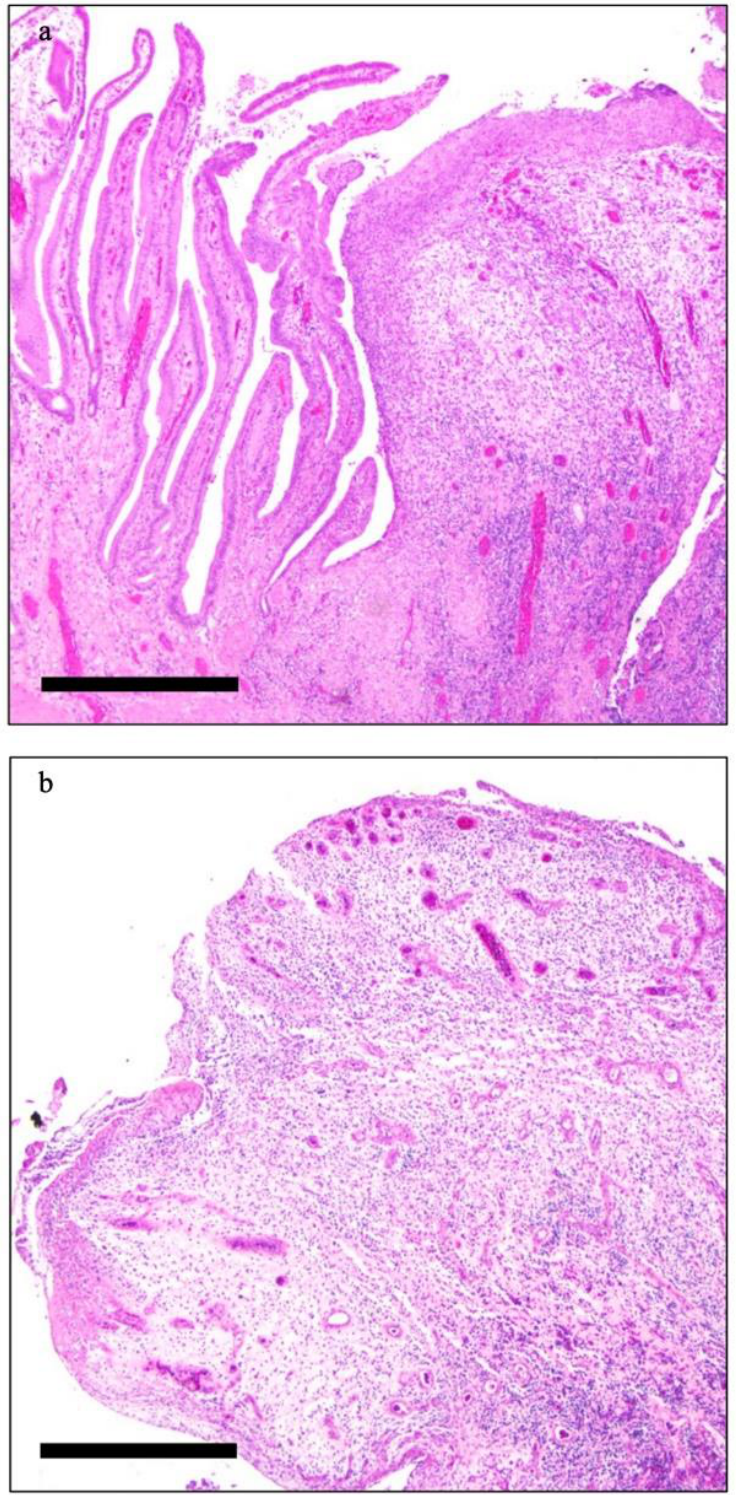
Figure 2. Histological image demonstrating papillary hyperplasia and an inflammatory pseudopolyp ( a ) and particular representative picture of one of the described inflammatory pseudopolyps observed in the gallbladder showing an ulcerated sessile mucosal projection characterized by edematous vascularized stroma with mixed type inflammatory infiltration ( b ) (scale bar 500 um). Acute acalculous cholecystitis, even complicated by perforation, often occurs in post- surgical adults while in children it is often caused by infectious disease or immune-medi- ated disorders. Moreover, it can be associated with cardiovascular diseases, in particular with coronary artery disease and in children with Kawasaki Disease [1–4]. The etiology of acalculous cholecystitis is often unknown, even though it has been correlated with biliary hypokinesia and local ischemia [5–8]. The radiological literature regarding rare pseudotumors like GIP, which represents 5–10% of all gallbladder polyps, is scarce, and, even if they are usually multiple and small (<10 mm), a differentiation from benign and malignant tumors might be challenging. Mu- cosal irritation, granulation, and fibrous tissue, usually due to gallstones and/or chronic inflammation may cause GIPs [9–11]. The rarity of our case in which the occurrence of GIP is probably related to acalculous cholecystitis subsequent to acute coronary artery disease, is highlighted by the results of the brief literature search, without any restrictions on language and publication date, we conducted on Pubmed on the 4 January 2022. Indeed, using the keywords “(gallbladder